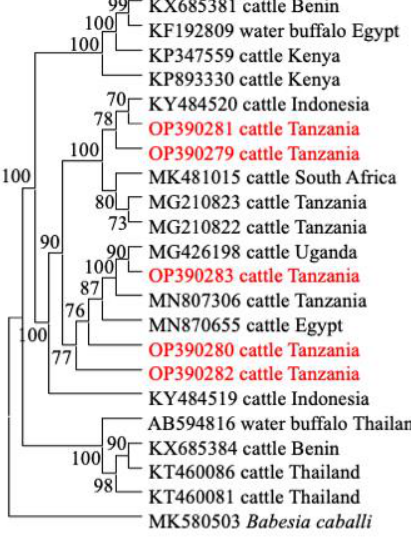
Figure 3. The phylogenetic analysis of Babesia bigemina identified in this study, based on the ( RAP-1a ) gene. The tree was constructed by MEGA version 11 using the maximum likelihood method, the confidence of occurrence of the nodes was assessed by bootstrap in 1000 replications. The sequences of this study are shown in red. Babesia caballi (MK580503) was used as an outgroup.